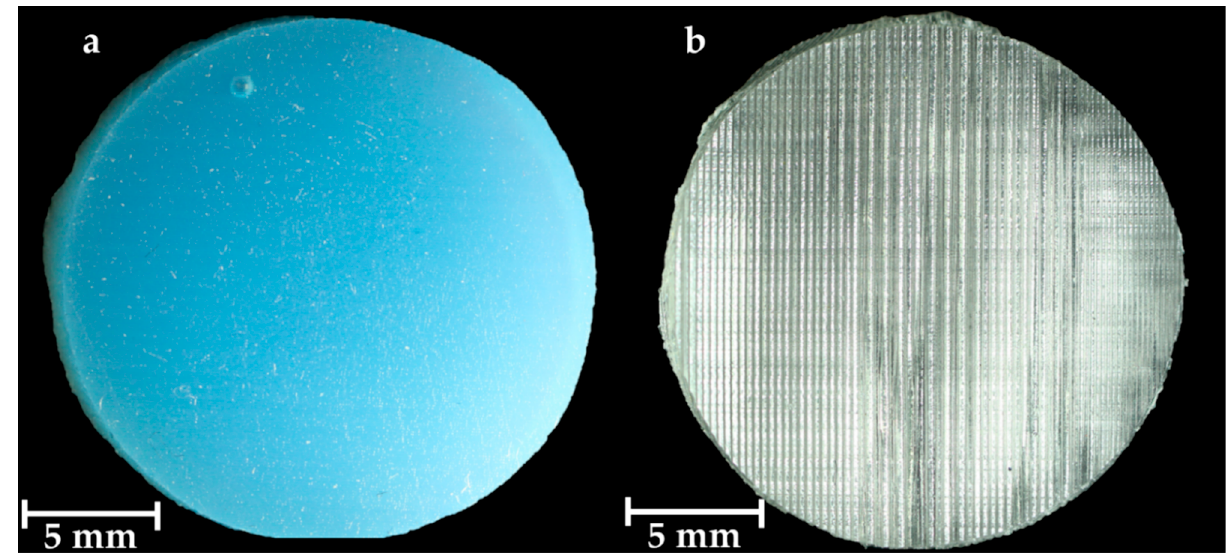
Figure 6. Pictures of both sample types. The Replisil 9N sample with a macroscopic air enclosure in the upper left quarter ( a ). The Formlabs Elastic 50A sample with vertical and parallel arranged grooves ( b ).